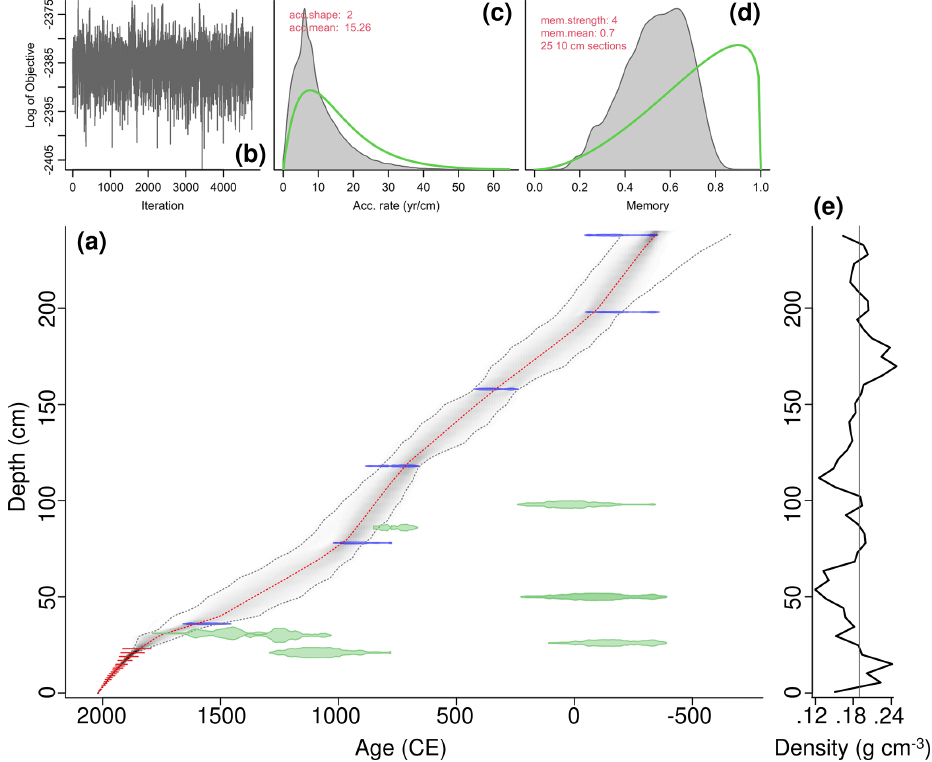
Figure 2. (a) Bayesian age-depth model applying Bacon (Blaauw and Christen, 2011) to several types of determined sediment ages (red = Pb / Cs; blue = 14 C bulk sediment; green = 14 C macrofossils; grey lines = 2 σ range; red line = median). (b) Model iteration log. (c, d) Prior (green line) and posterior (grey area) distributions for accumulation rate and memory, respectively. (e) Dry bulk density of sediment core EN18232-3 (grey line =